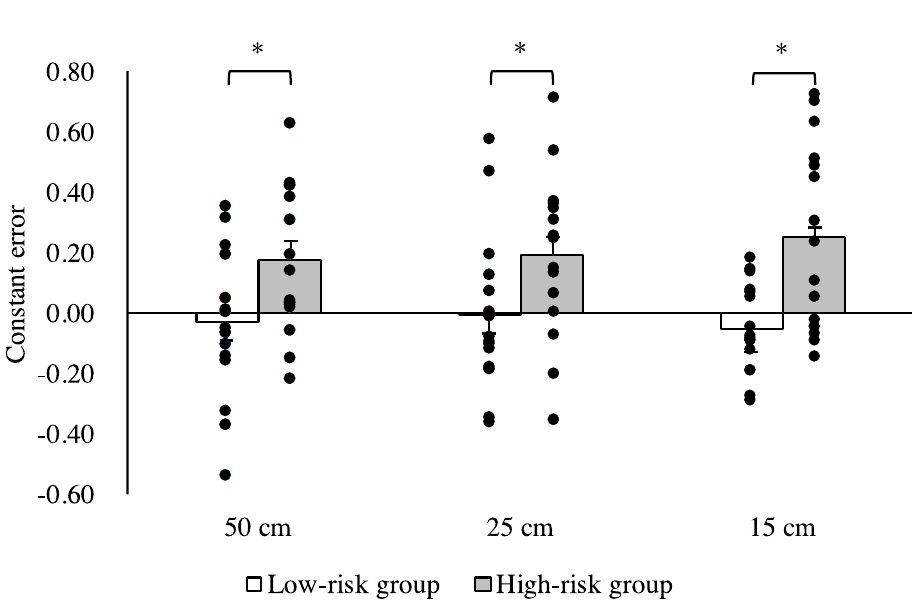
Figure 3. Comparison of constant error between the high- and low-risk fall groups for each of the three walkway widths. Data are presented as the mean ± standard error. * p < 0.05.